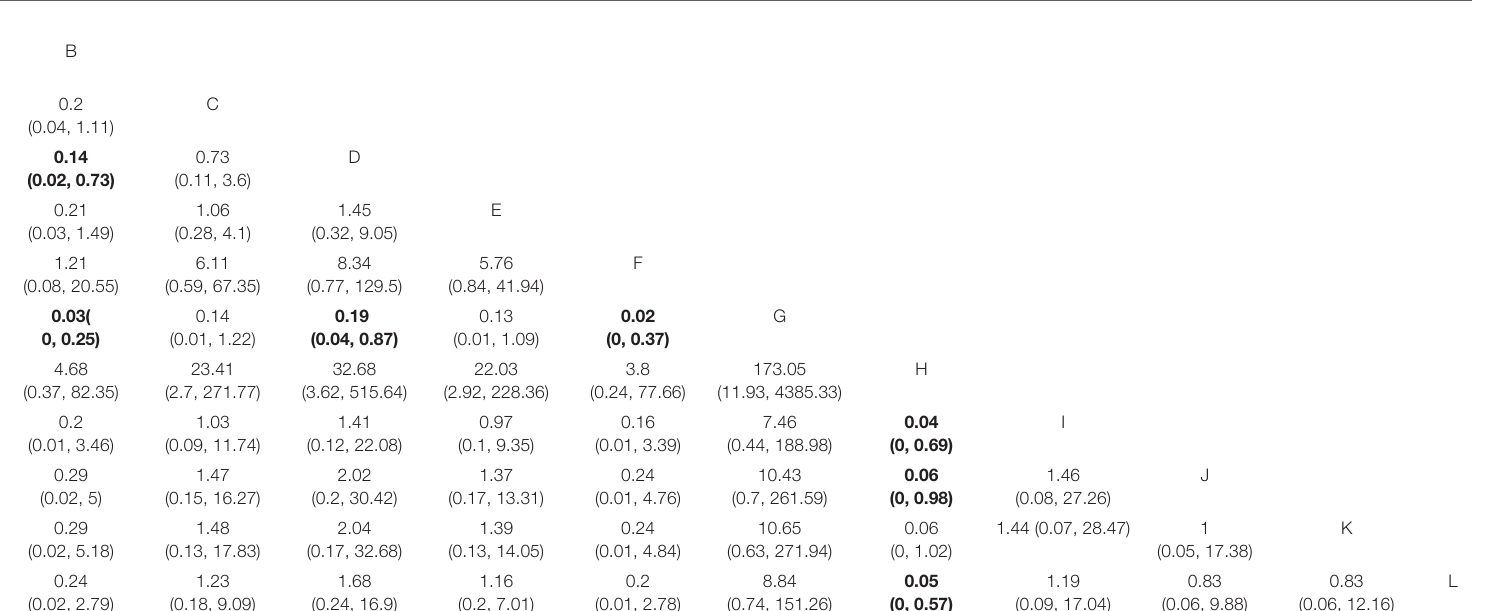
TABLE 2 | League table of all CER